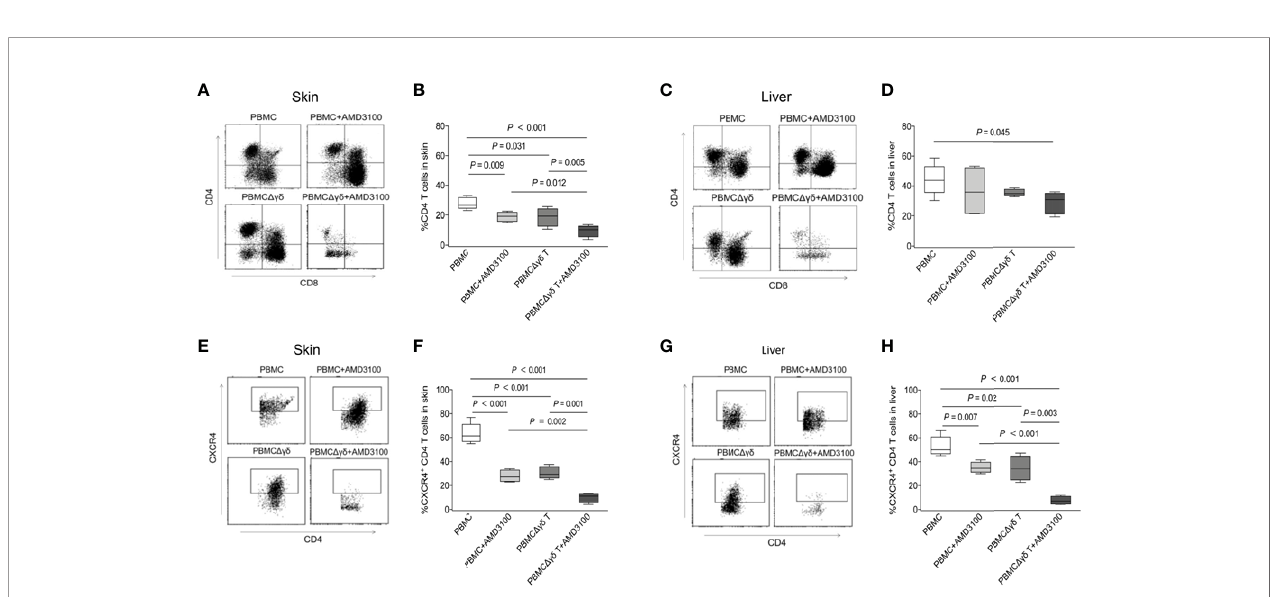
FIGURE 8 | Impacts of gd T cells and inhibitor of CXCR4 signaling on the migration of CD4 T cells in humanized mice. Presence of CD4 T cells was detected by fl ow cytometry in the skin (A, B) and liver (C, D) of mice among each group. CXCR4-expressing CD4 T cells were detected by fl ow cytometry in the skin (E, F) and liver (G, H) of mice among each group. n = 4, P values are shown on the